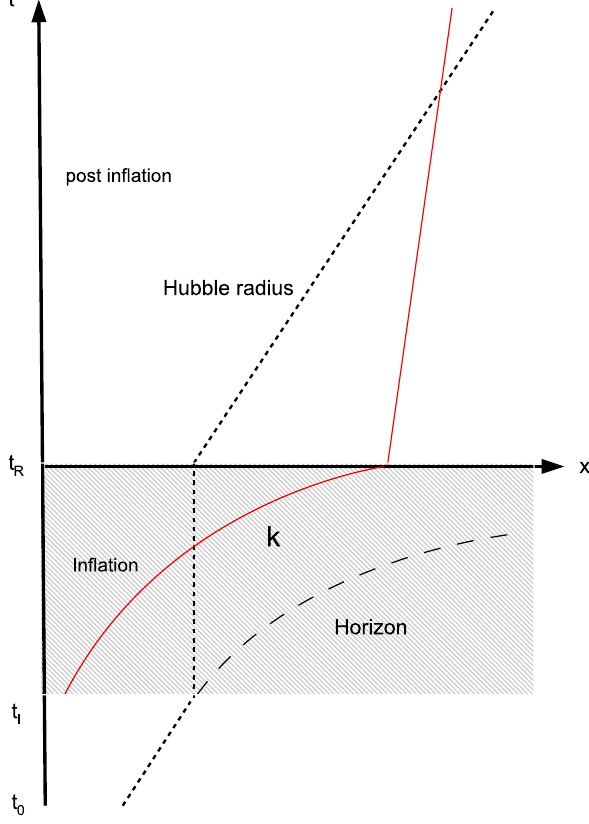
Fig. 1 Space-time sketch of inflationary cosmology. The vertical axis is time, the horizontal axis corresponds to physical distance. The period of inflation lasts from t i until t R . Before t i and after t R the universe is in a phase dominated by radiation. The time t R can be viewed as the start of the the Standard Cosmology epoch of the inflationary scenario. The solid line labelled k is the physical distance between two points at rest in the expanding space. This distance corresponds to the scale of a fluctuation. Note that the horizon (the forward light cone of a point at the Big Bang) begins to deviate exponentially from the Hubble radius as the inflationary phase